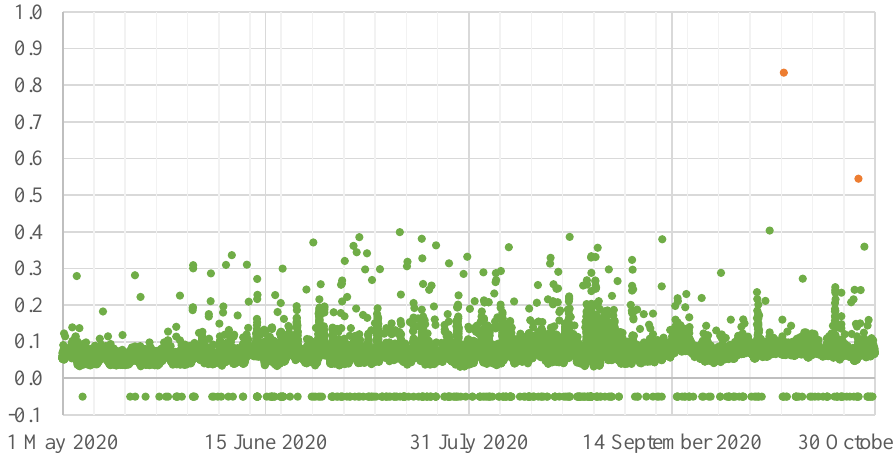
Figure 2. Global power quality index changeability for MV_Line.